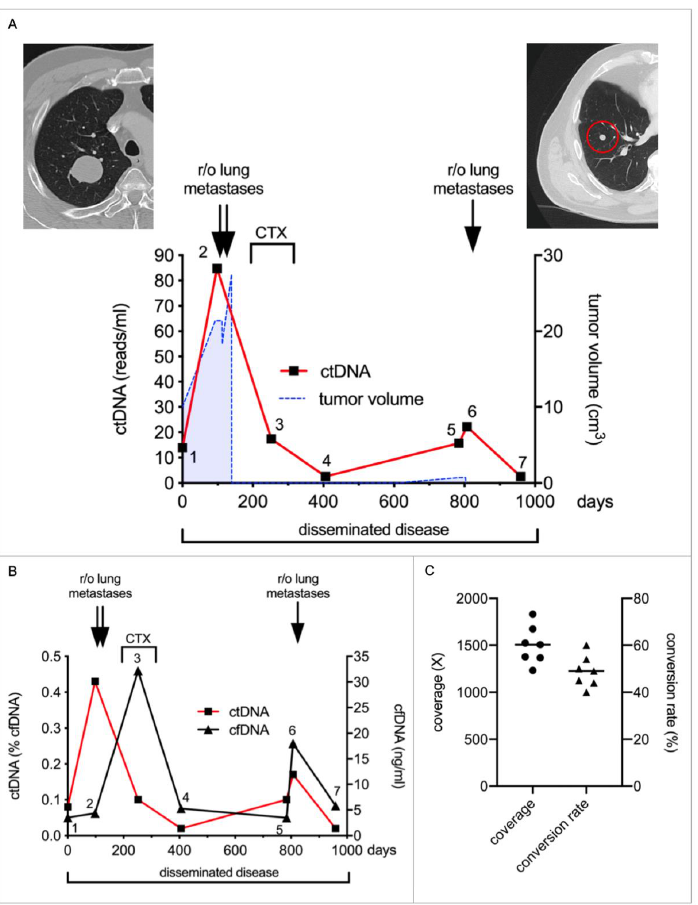
Figure 3. Monitoring of treatment response in a patient with a metastatic Undifferentiated Pleo- morphic Sarcoma. ( A ) The patient suffered from an Undifferentiated Pleomorphic Sarcoma of the thigh, which was resected 1 year prior to inclusion in the study. On presentation, lung metastases were suspected on CT imaging (left upper image) and subsequently removed on two separate op- erations (double arrows). Treatment was followed by adjuvant chemotherapy (CTX). The patient was in complete remission until a new lung lesion was detected 1.5 years later (red circle in right upper CT image). This lesion was again resected (single arrow). We obtained seven plasma samples during the course of his treatment. ctDNA inclined with increasing tumor burden and declined after tumor resections and during CTX (red line). It never reached baseline following treatment, indicat- ing sustained MRD. Tumor volume, as deduced from repeated imaging, is shown in blue. ( B ) De- picted are the cfDNA concentrations (black line) and relative amounts of ctDNA (red line) in the same samples. ( C ) shows the coverage (circles) and conversion rate (triangles) of each sample after building UMI consensus families. Means are illustrated by horizontal bars.